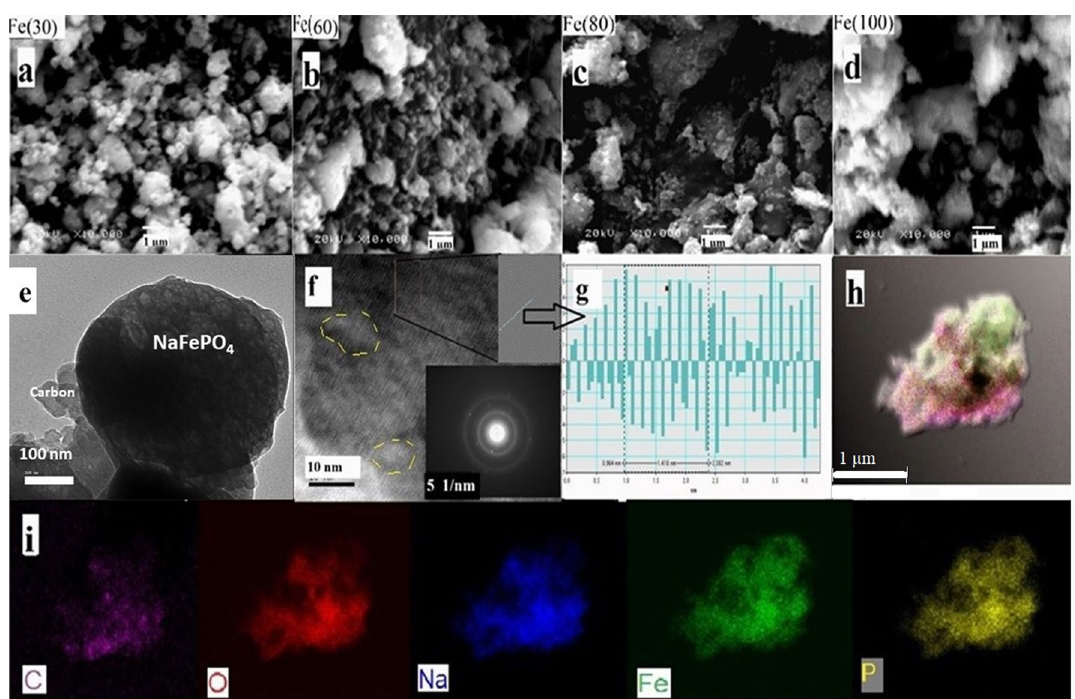
Figure 4. ( a – d ) SEM images at ×10,000 for Fe(30), Fe(60), Fe(80) and Fe(100) respectively. ( e ) Low magnification TEM image showing carbon compositing with NaFePO 4 particles, ( f ) High magnification TEM image and SAED image for NaFePO 4 spot, ( g ) FFT images and IFFT profile of Fe(60) for selected area along (240) plane and ( h , i ) Elemental mapping showing C, O, Na, Fe, and P distribution on the selected